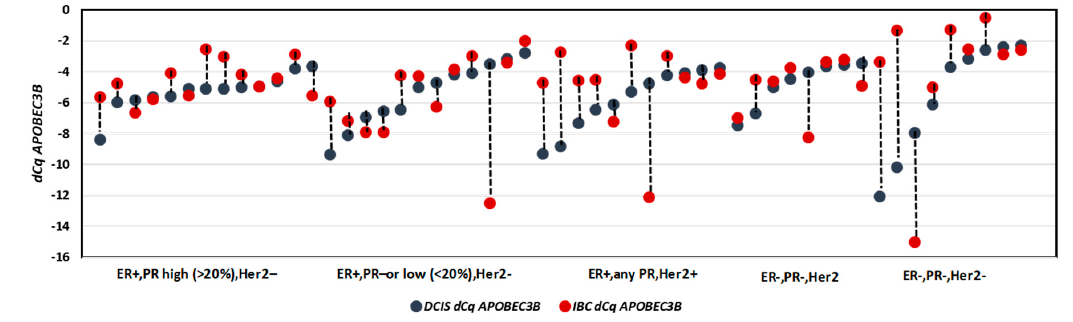
Figure 2. APOBEC3B expression levels in paired DCIS and IBC ( n = 53). Wilcoxon Signed Ranks Test p = 0.082.